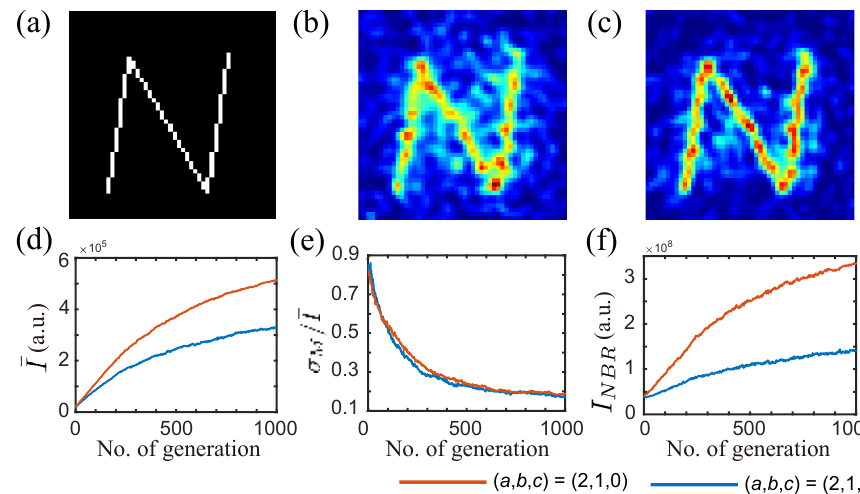
Figure 3. Simulation results of SBGA. ( a ) Target N pattern. ( b ) Optimal speckle image with two dis- criminants ( a , b , c ) = ( 2,1,0 ) . ( c ) Optimal speckle image with three discriminants ( a , b , c ) = ( 2,1,1 ) . Progress of ( d ) average intensity, ( e ) relative standard deviation, and ( f ) neighboring intensity with the number of generations. ( b , c ) were normalized separately.